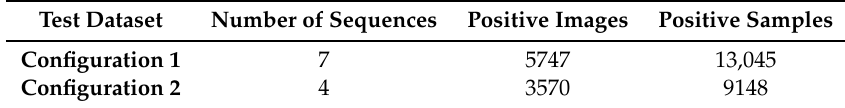
Table 1. Test dataset statistics. Positive images each contain either one or more than one person, and each instance of people appearing in an image is considered as one positive